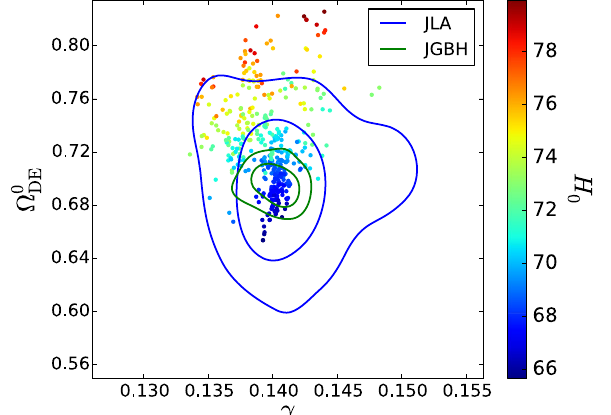
Fig. 15 The effect of varying H 0 on the degeneracy between Ω 0 in the contour enclosing 68 and 95% confidence intervals